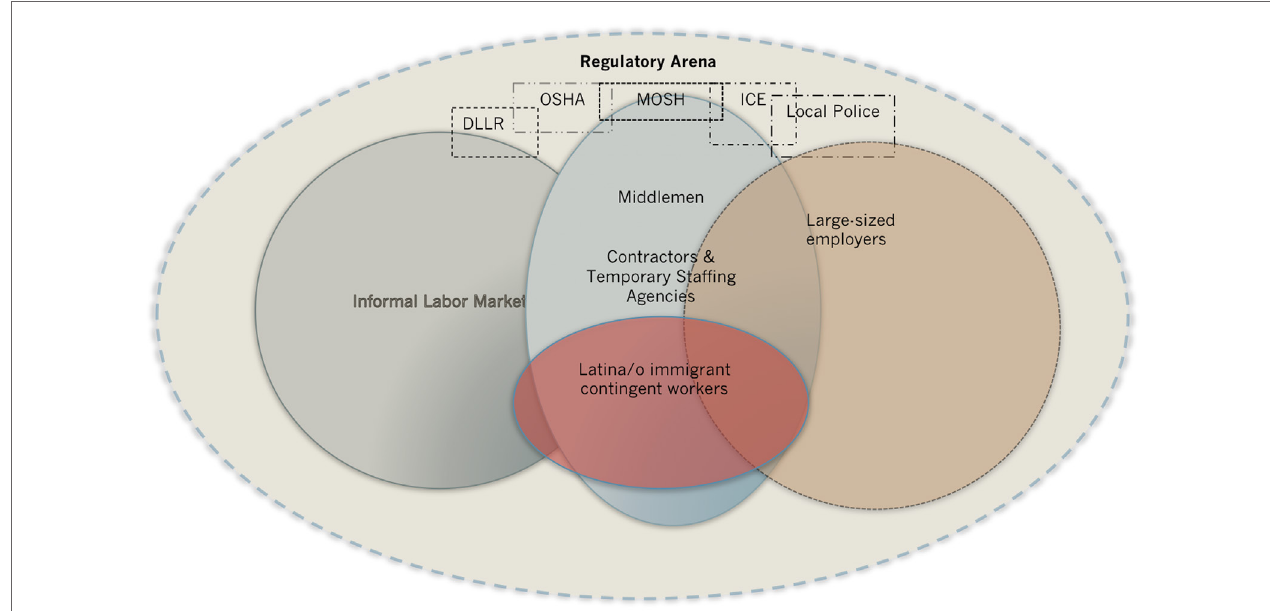
FigUre 1 | Diagram of the regulatory arena that shapes Baltimore latina/o immigrants’ psychosocial stressors